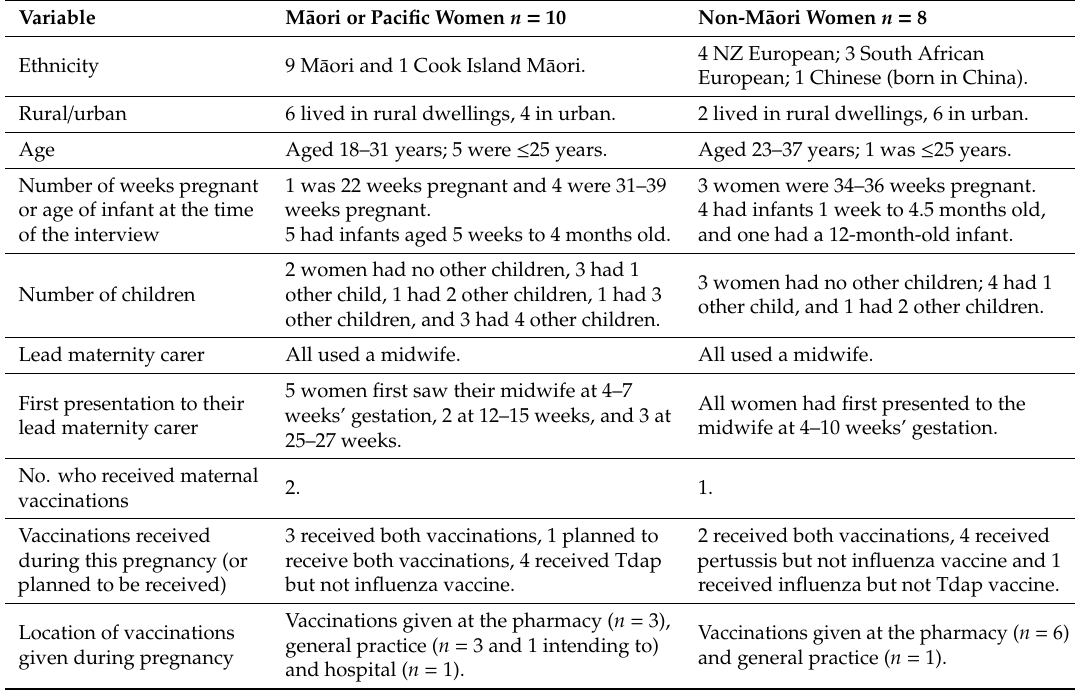
Table 1. Characteristics of the enrolled and interviewed women ( n = 18).